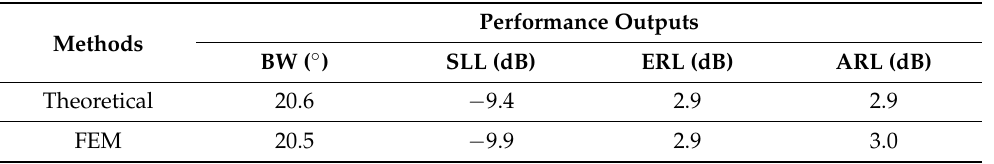
Table 4. Comparative values of the performance outputs of the theoretical and finite element analysis beam patterns of the